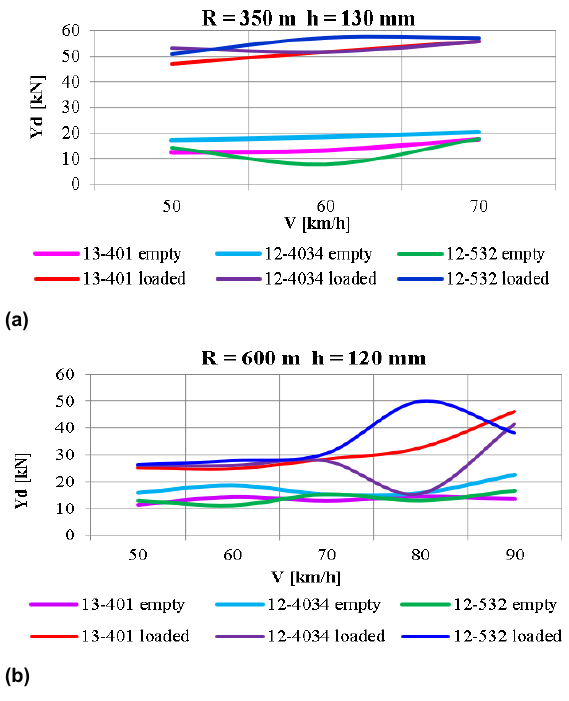
Figure 19. Variation of the guiding force acting from the track to the wheel with the motion speed: (a) R=350 m curve; (b) R=600 m curve The hopper wagon has the lower values of the wheelset hunting when moving along the R =600 m curve (Fig. 20, b) in the empty mode and the flat wagon has the largest values of ψ at speeds of 50 and 90 ws km/h. The values of ψ also increase for an empty open ws wagon when moving at a speed of 80 km/h along curves of mean radius and they significantly differ from the other range of studied speeds.